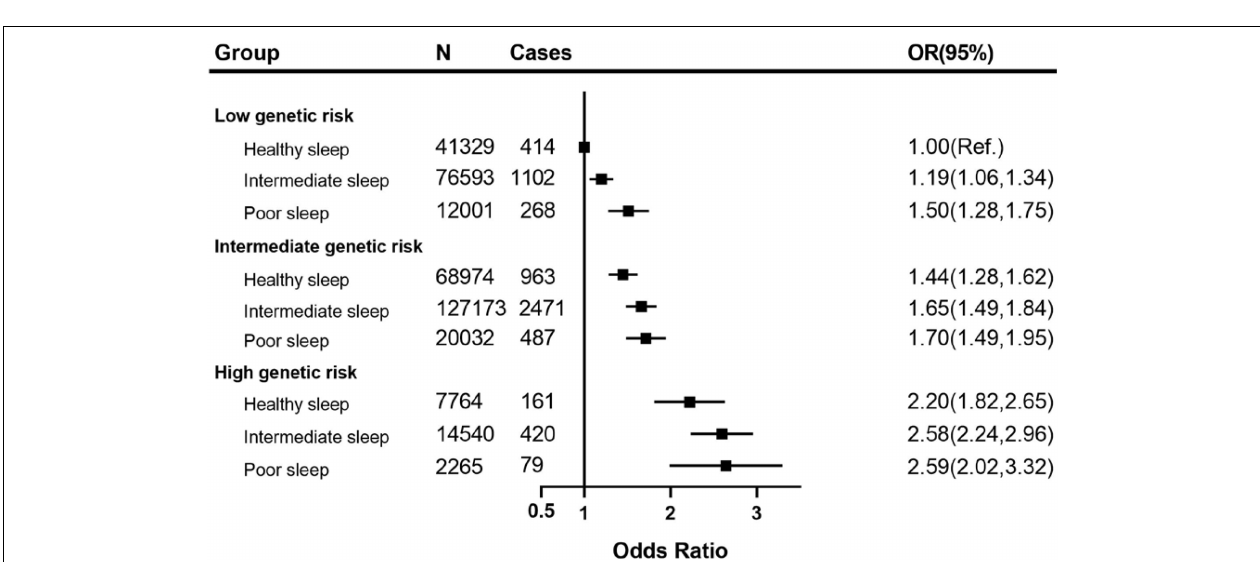
FIGURE 2 | Adjusted ORs for healthy sleep score (per 1 score increment) associated with CKD in subgroups. The vertical line indicates the reference value of 1. The ORs with corresponding 95% CIs have been adjusted for age, sex, ethnicity (White/others), education (university or college degree/others) and the Townsend index (continuous), smoking status (current, ever, never), drinking status (drinks, continuous variable), physical activity (at goal or not), overweight and obesity (BMI ≥ 25 kg/m 2 ), systolic blood pressure, diabetes (yes/no), use of blood pressure-lowering medications (yes/no) and use of diabetes medications (yes/no). CKD, chronic kidney disease; CI, confidence interval; OR, Odds Ratio.